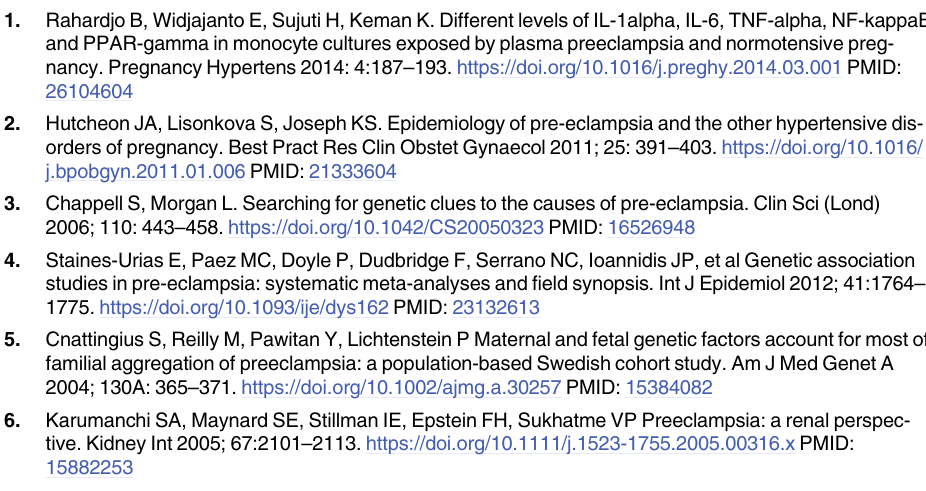
S1 Table. Maternal and fetal genotypes. S2 Table. Comparison of NEMO gene expression in umbilical cord blood of preeclamptic and control